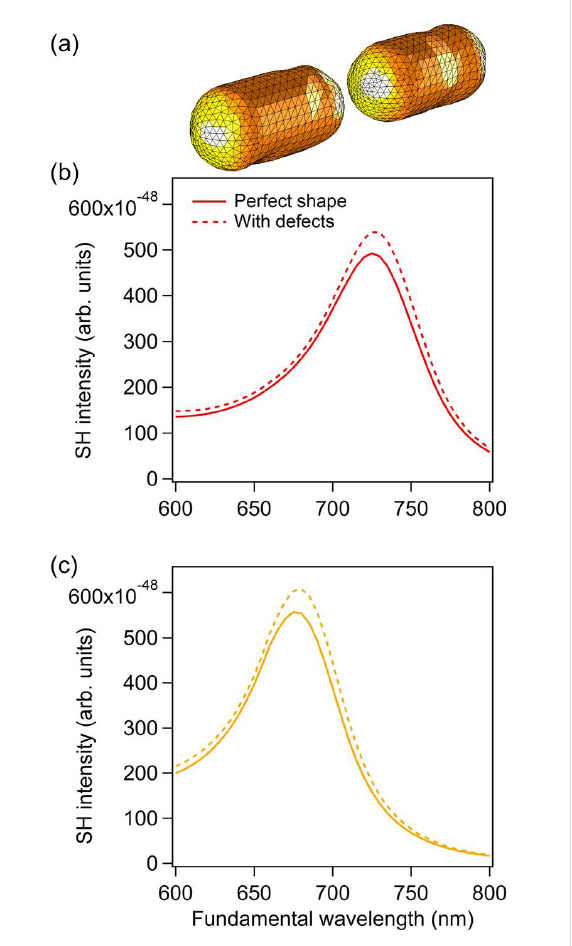
Figure 6: (a) Mesh used for the dimers with defects. In this example, the gap is 20 nm. Far-field second harmonic intensity for a dimer made of perfect nanorods (solid lines) and with defects (dashed lines). The gap between the nanorods is 5 nm for panel (b) and 20 nm for panel